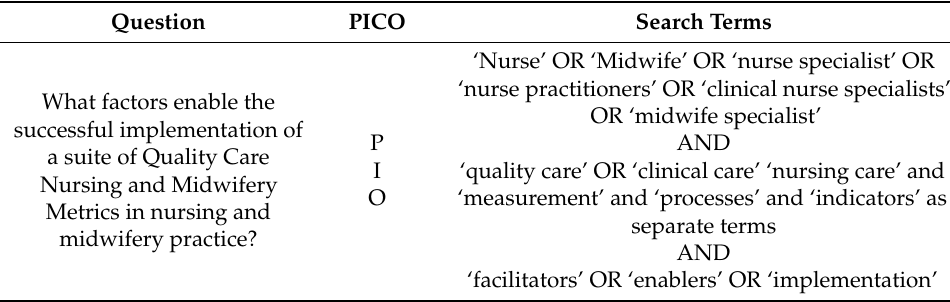
Table 2. PICO search terms used in the review of the